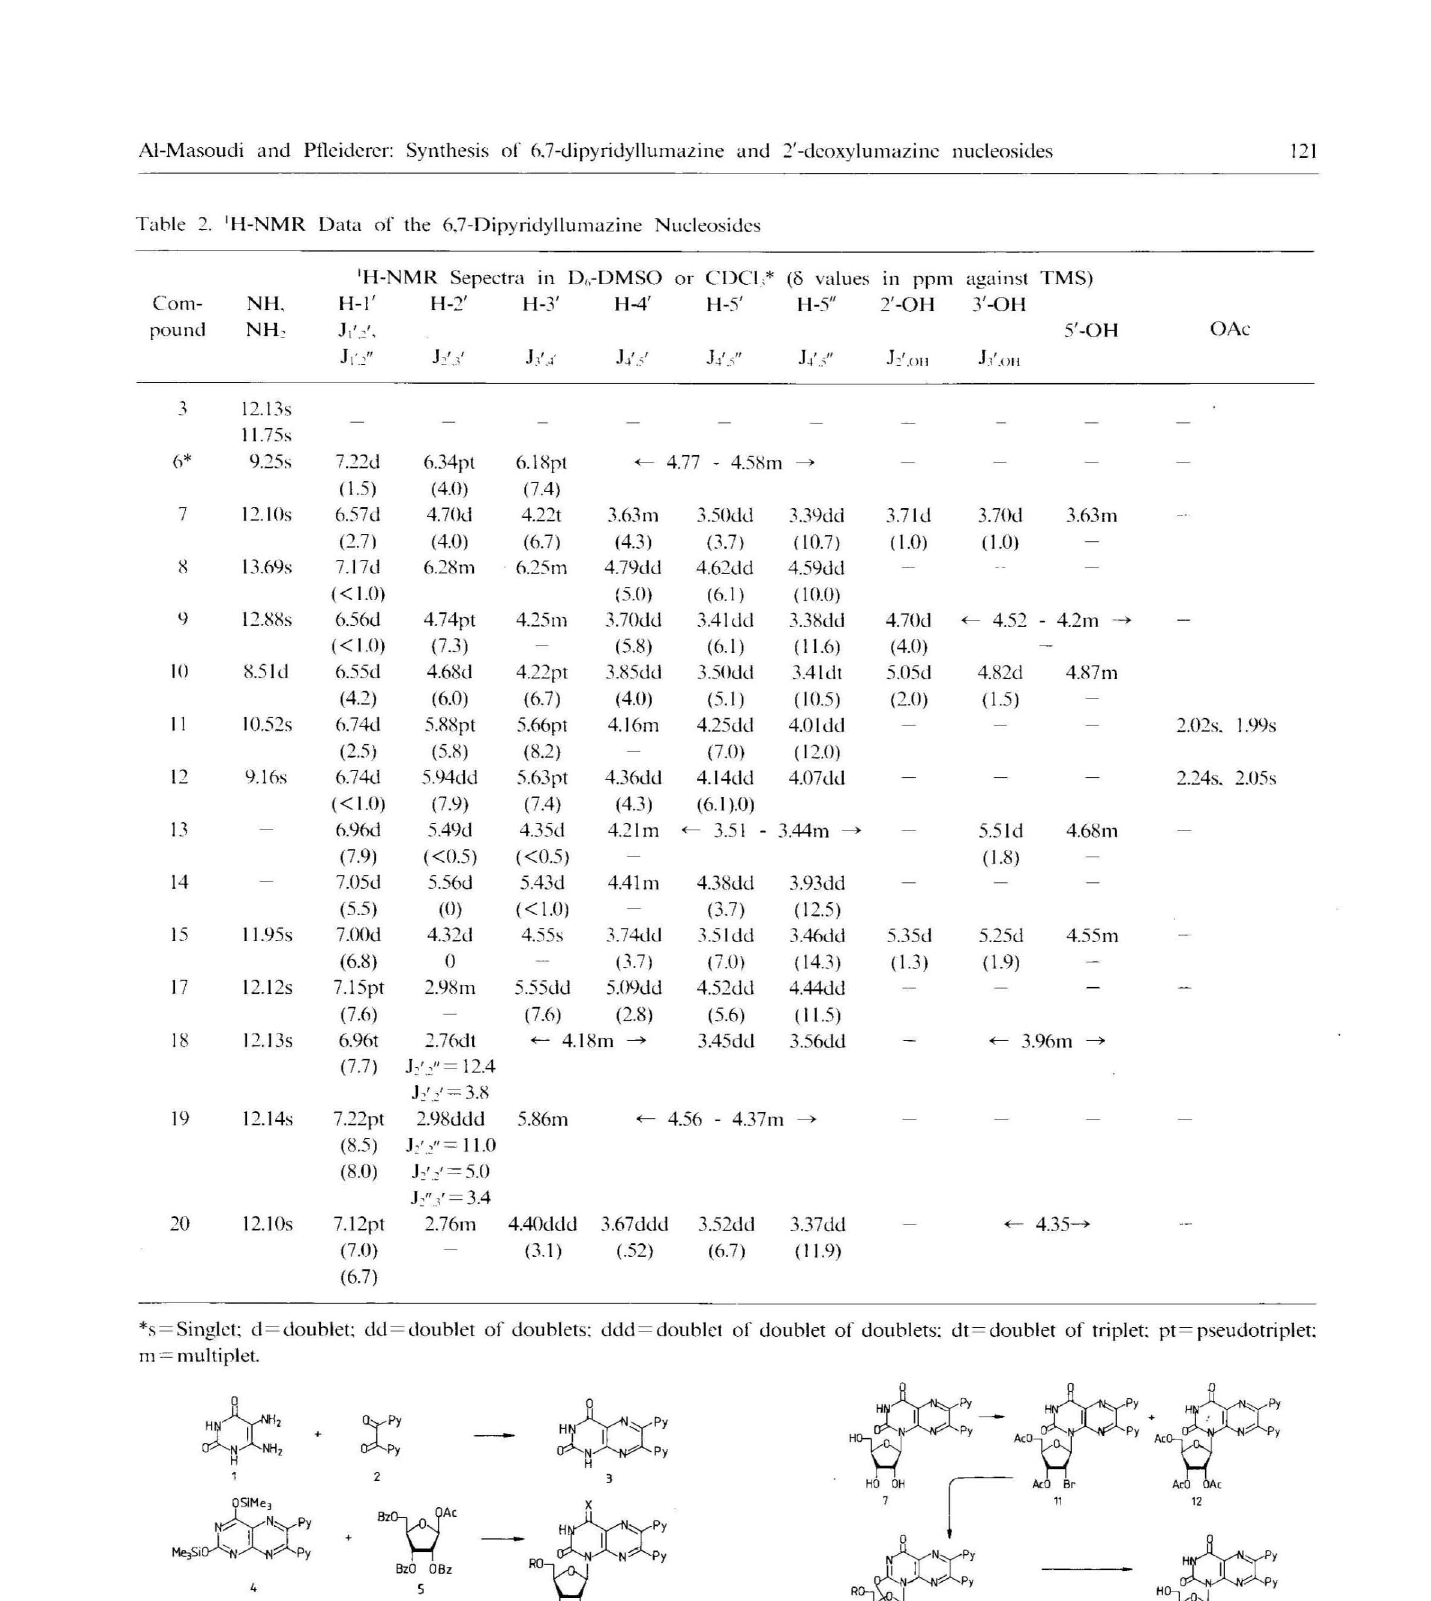
Table ') 'H-NMR Data of the 6,7-Dipyridyllumazine